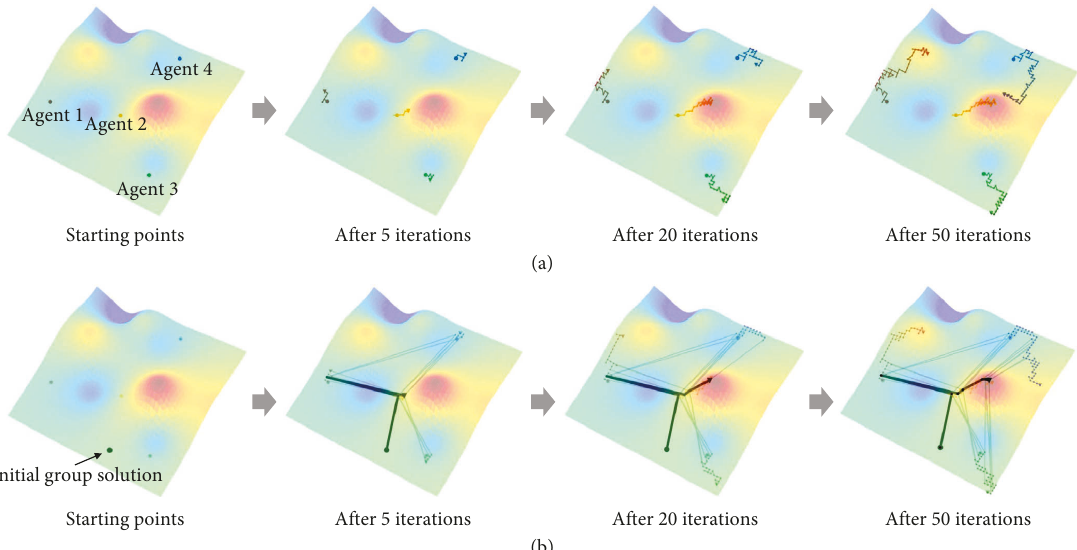
Figure 3: A schematic illustration of agents’ searching process on a two-dimensional problem space. (a) Four agents independently search for the maximum solution using the “hill-climbing” strategy [70]. The starting and ending points are represented as a round dot and a triangle dot, respectively. The searching traces of agents 1, 2, 3, and 4 are displayed in thin brown, orange, green, and blue lines, respectively. (b) A group of four agents collaboratively search for the maximum solution using the “hill-climbing” strategy. The large round and triangle dots represent the starting and ending points of group searching. The group’s searching trace is displayed in thicker black lines. Note . Each point in the problem space represents a solution, while the corresponding color denotes the value of the point. For example, dark red refers to a high value, whereas dark blue refers to a low